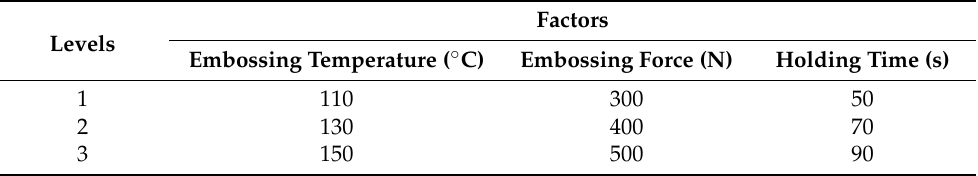
Table 2. Molding test process